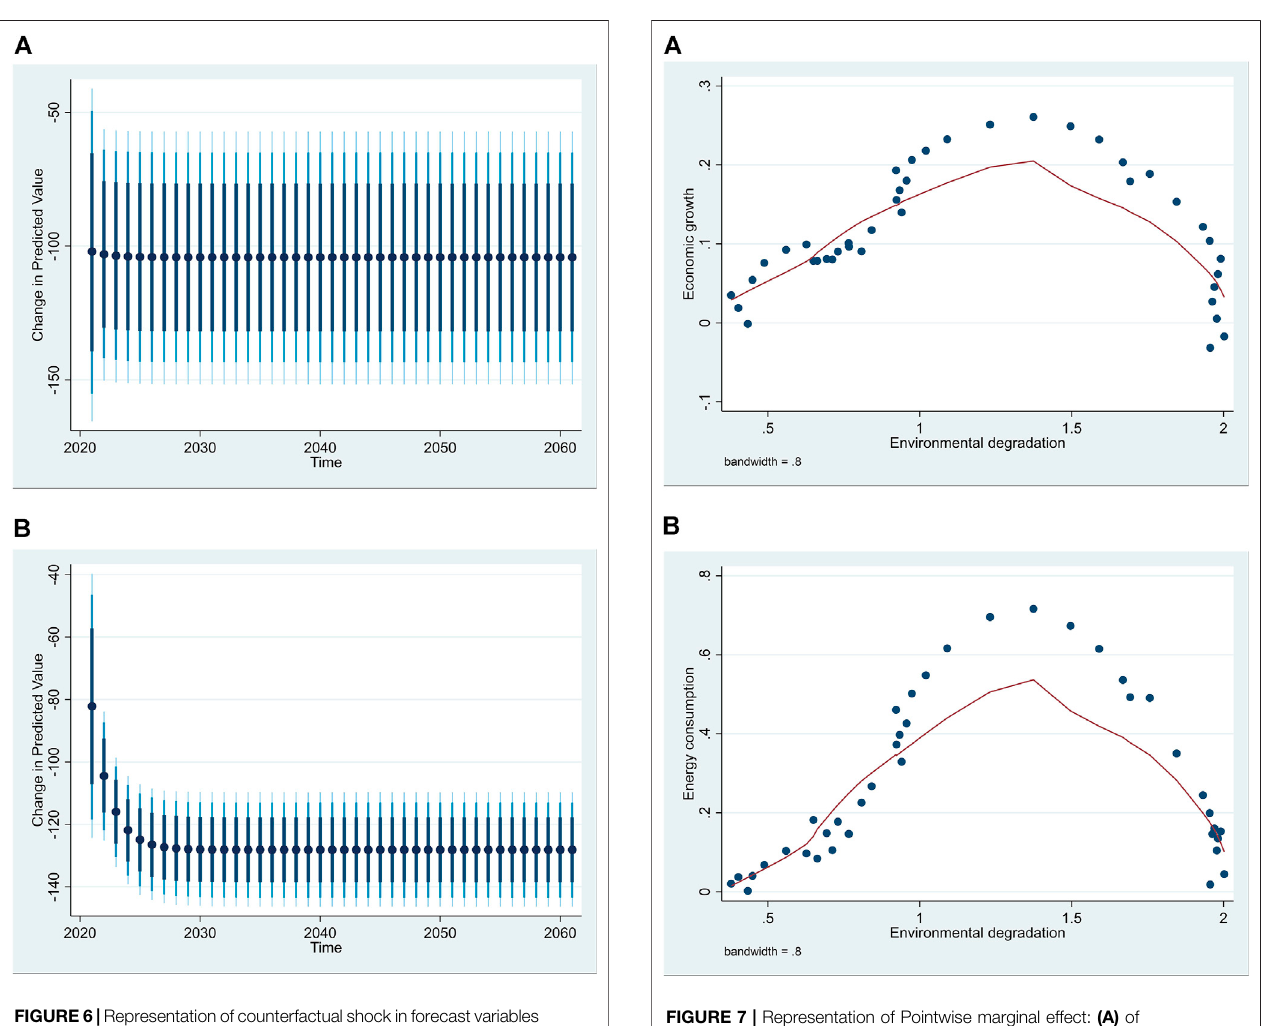
FIGURE 7 | Representation of Pointwise marginal effect: (A) of economic growth; (B) of energy